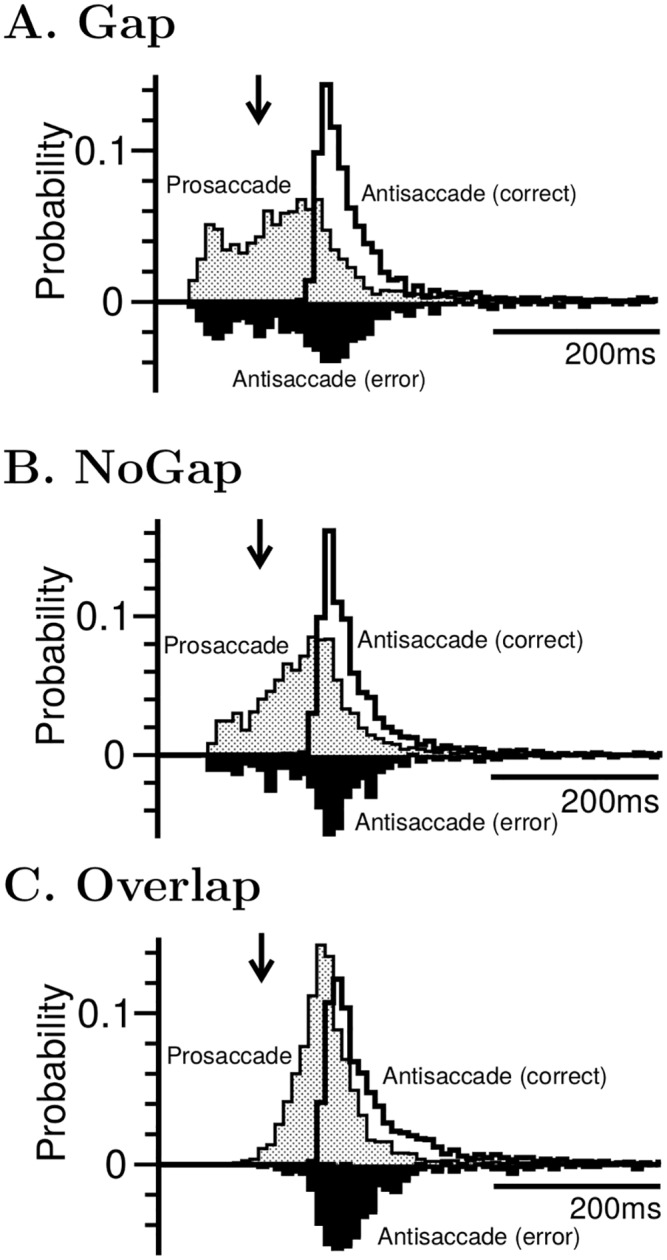
The model produces reaction time distributions in consistent with those observed in experiments.Here we plot the distributions for antisaccade (correct: white, error: black) and prosaccade (shaded) in the A Gap, B NoGap and C Overlap tasks. In the Gap task, the offset of the fixation signal prior to the onset of the target weakens the subject’s ability to withhold the gaze, which is reflected in the large number of express saccades (RT < 125ms, indicated by arrows) both in the prosaccade and in the erroneous responses in antisaccade trials. This trend is less significant in the NoGap task and disappears in the Overlap task. Due to the relatively small percentage of erroneous responses, the heights of their distributions have been magnified by three-fold for easy viewing.